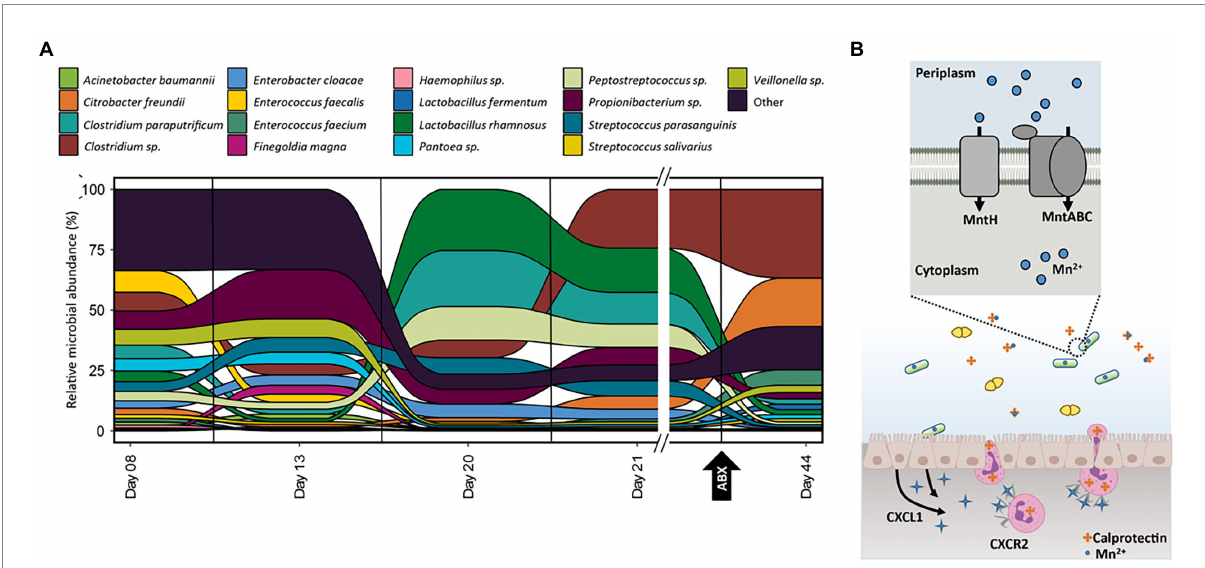
FIGURE 5 (A) Relative abundance of organisms at each time-point for samples collected for infant 39 based on the summed protein expression of each organism. Taxonomic assignment of proteins determined previously in Brown et al. (2018). (B) Graphical representation of manganese-related activities between the host immune system and L. rhamnosus in infant 39 based on the pathways and proteins detected in samples from this infant. Additional proteins related to these processes, as well as microbial manganese/zinc non-specific transporters, are listed in supplemental